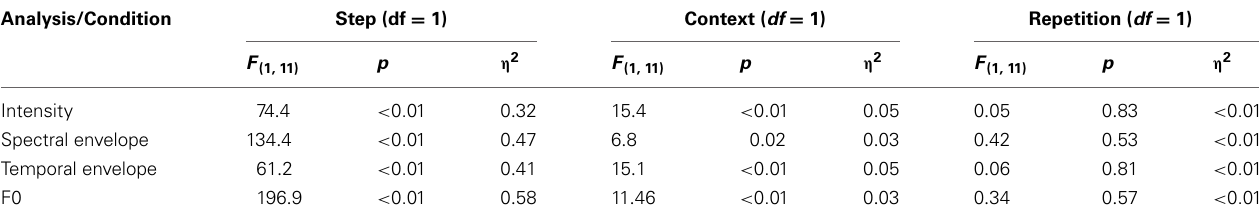
Table 2 | Results from four GLM analyses on difficulty ratings, η 2 (eta-squared).